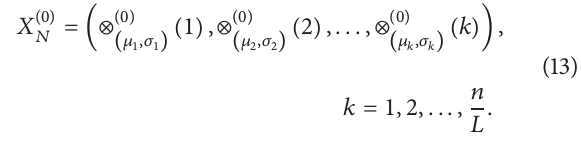
Algorithm 9 (grey clustering algorithm based on normality grey